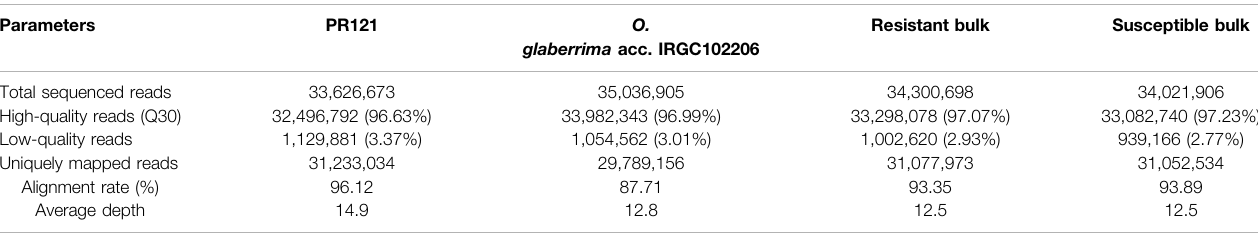
TABLE 4 | Statistical summary of BSA-seq data of parental lines, resistant bulk, and susceptible bulk.